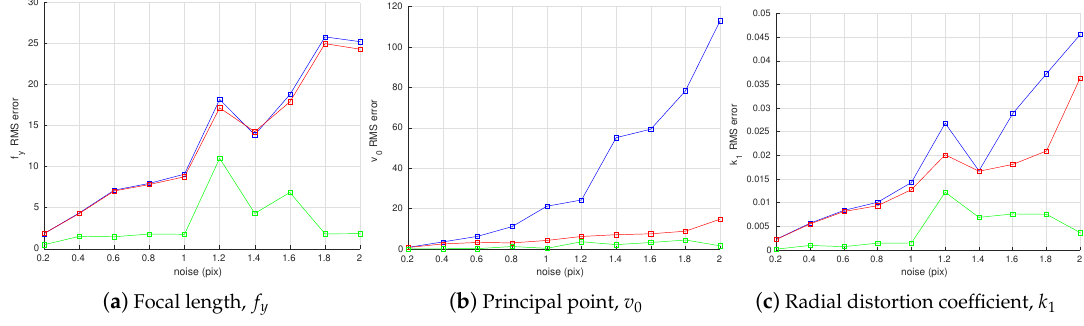
Figure 9. Root-mean-square error (RMSE) in camera intrinsic parameters w.r.t. camera observation noise. The blue, red, and green plots represent RMSE of the conventional method [19], the proposed method without joint optimization and the proposed method with joint optimization, respectively.